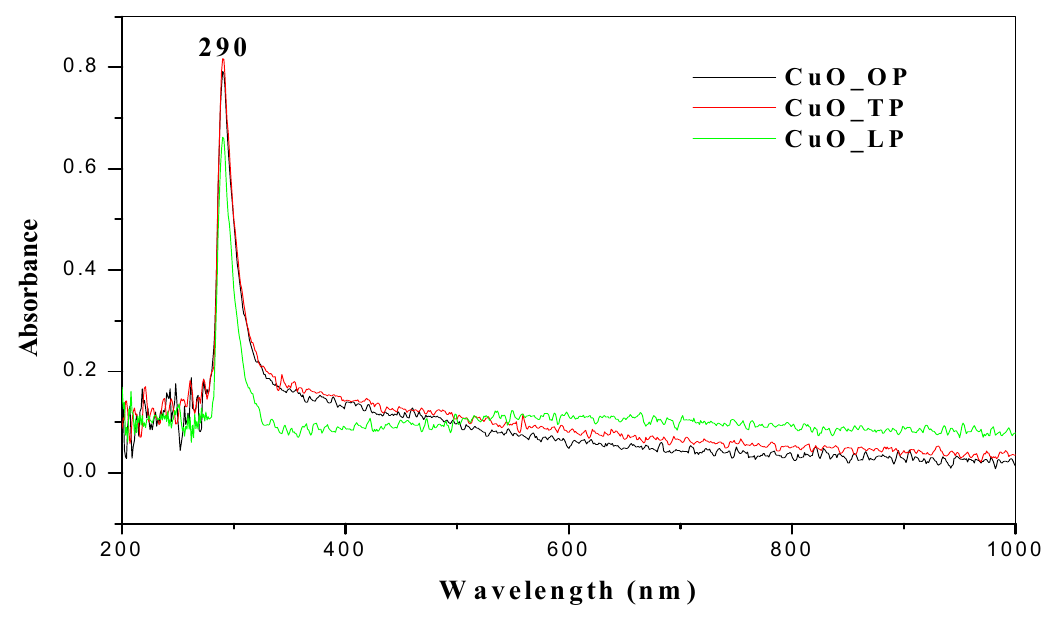
Figure 1. UV-Vis spectra of CuONPs from citrus peels extracted with distilled water solvent.